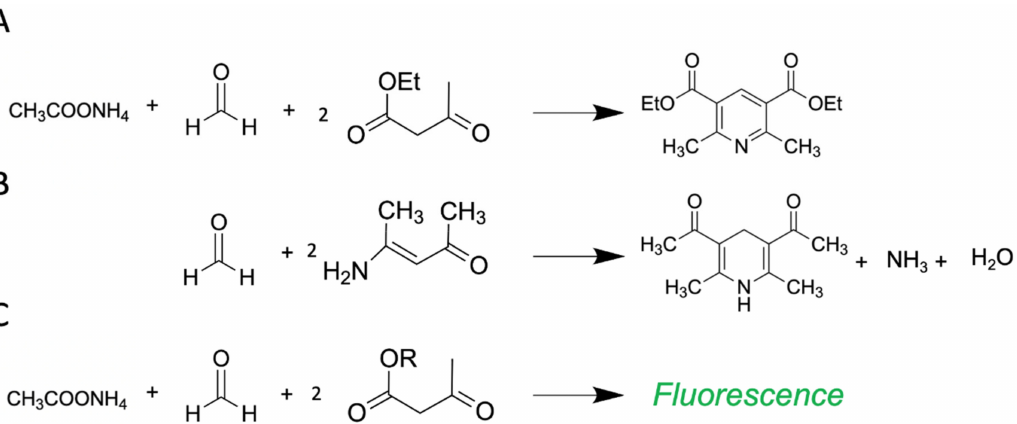
Figure 7. ( A ) Hantzsch reaction used for FA detection by Nash approach, ( B ) Fluoral-reaction with FA, and ( C ) polymer-based application of Hantzsch reaction. R denotes